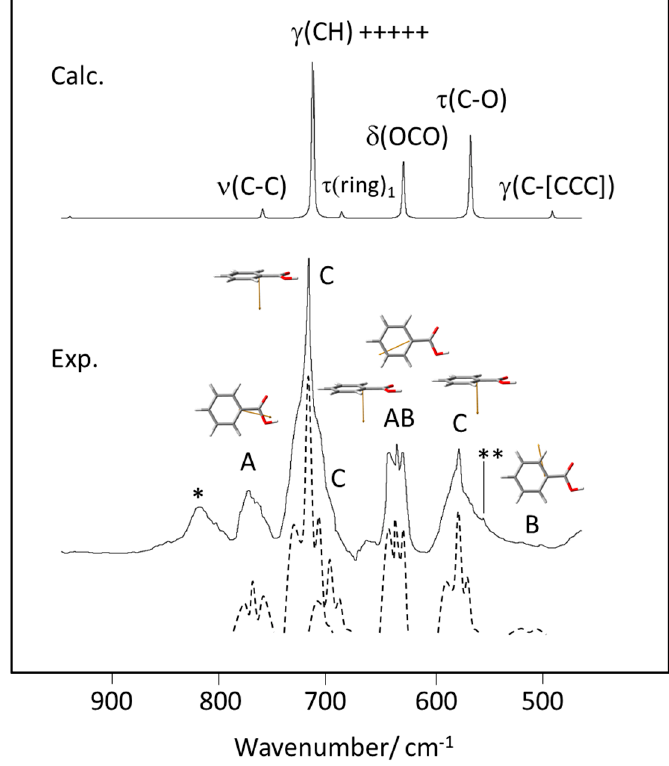
Figure 14. 900–450 cm –1 spectral region of the experimental (Exp.) gas phase infrared spectrum of benzoic acid, with indication of the band contour type (A, B, AB, C). The dashed figures are approximate deconvolutions of the experimental bands, drawn with increased resolution to highlight the characteristic bands profiles. The calculated (Calc.) spectrum is shown at the top of the figure, with indication of the band assignments. The drawings of the molecule show the the transition dipole moments (in orange color) for the different vibrations (see Figure 12 for orientation of the principal axes of inertia of the molecule). *-band due to an unknown impurity; **-band due to the combination tone τ (ring) 3 + w(COOH) (calculated values: 404 + 155 = 559 cm –1 (see Table 2).